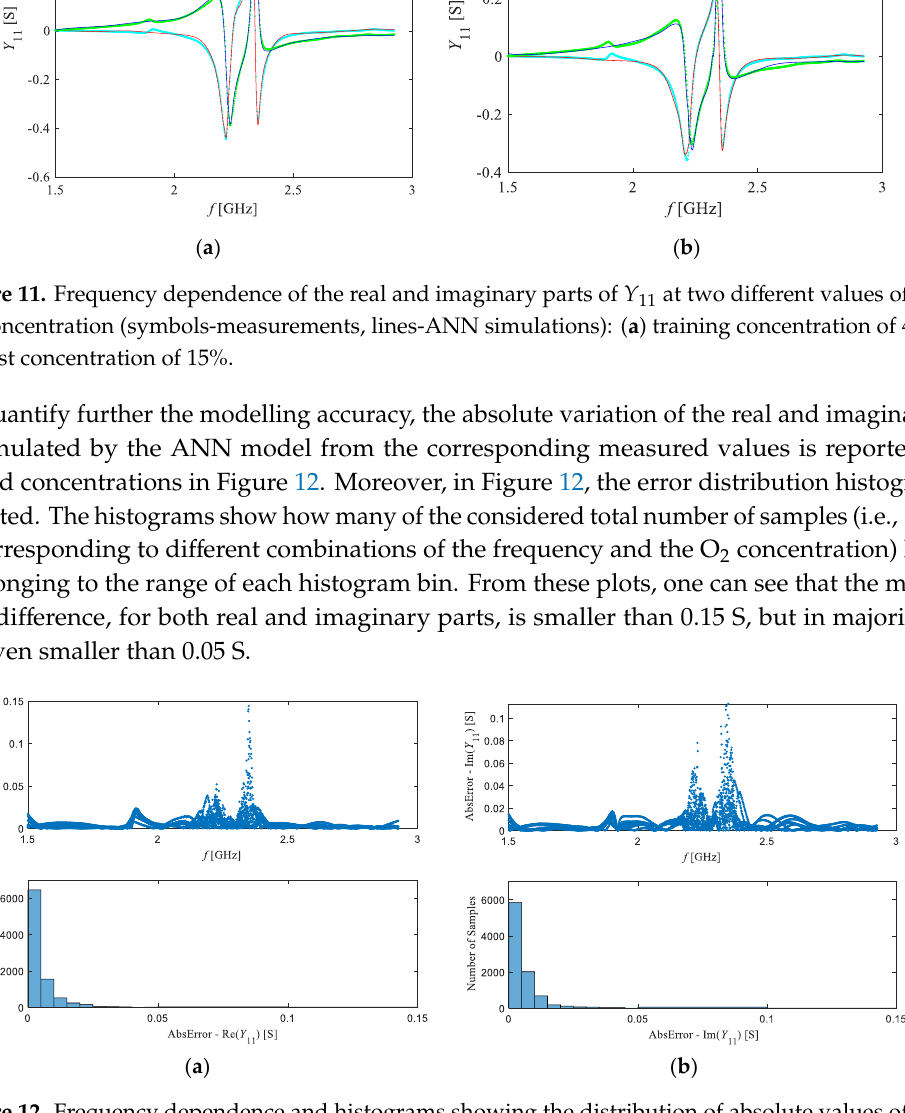
Figure 12. Frequency dependence and histograms showing the distribution of absolute values of the difference between the measured Y 11 and the corresponding values obtained by using the ANN model: ( a ) Y 11 real part; ( b ) Y 11 imaginary part.